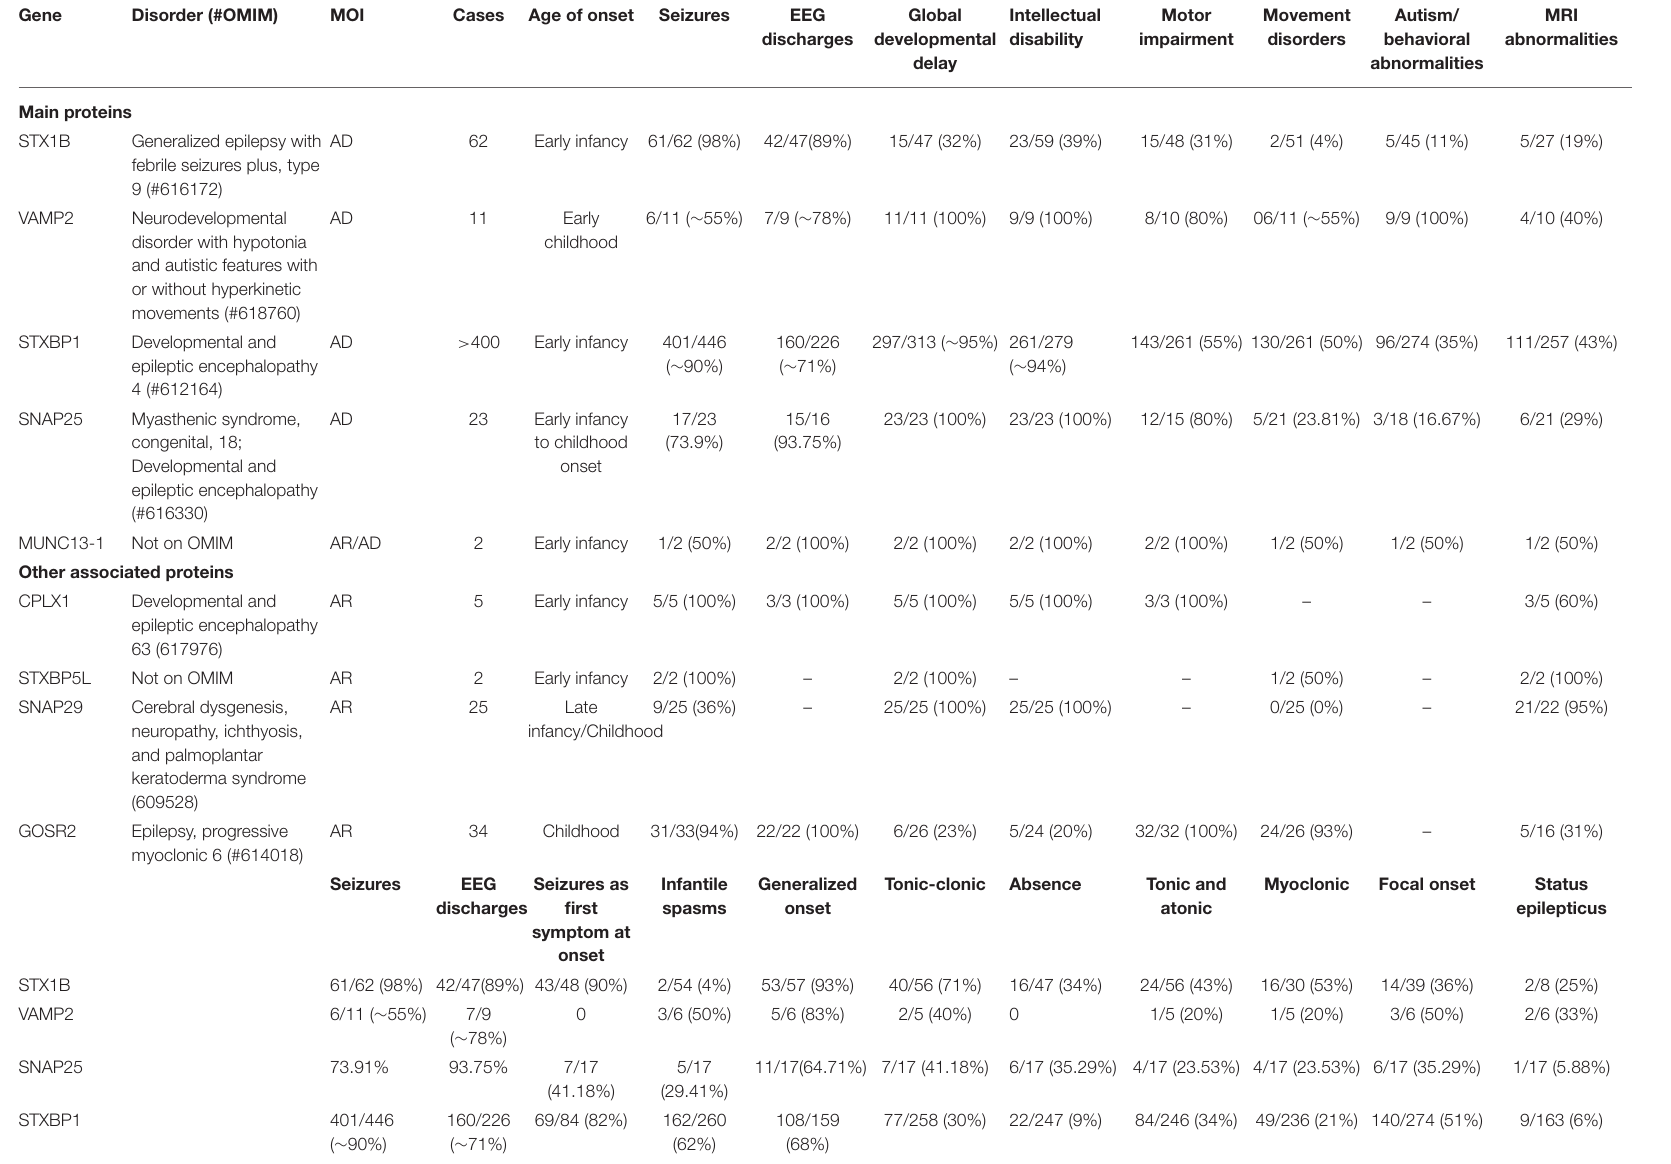
TABLE 2 | Main phenotypes associated with mutations in the SNARE